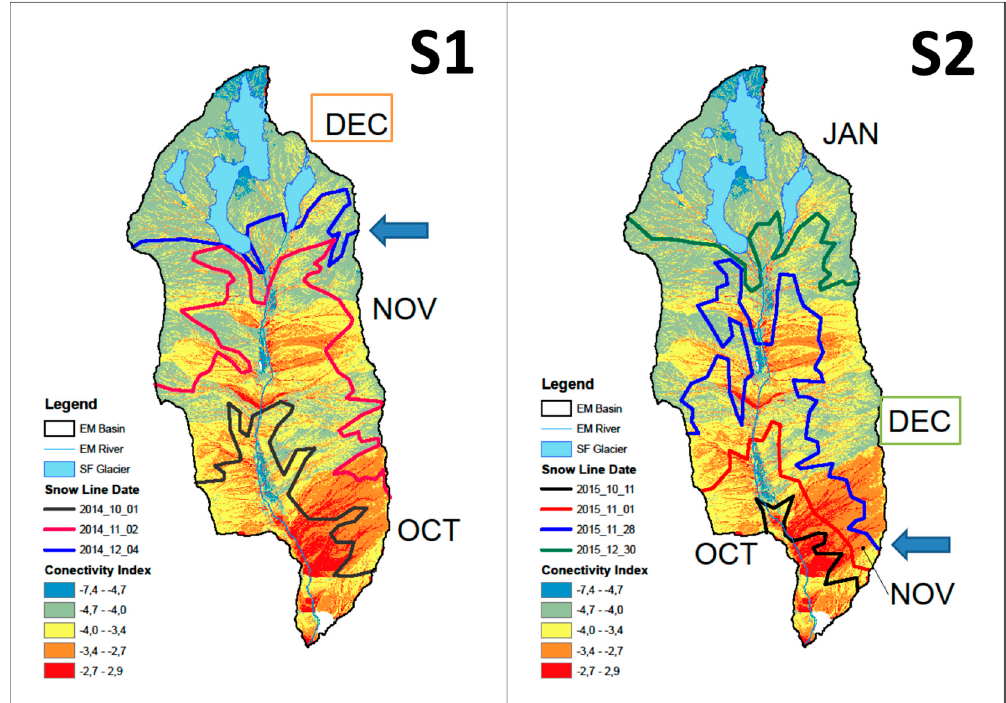
Figure 13. Connectivity map calculated using the connectivity index proposed by Cavalli et al. [7] and snow lines at the end of each month for the S1 ( left ) and S2 ( right ) ablation seasons. The color-coded lines on the map represent the zones between lines representing the limit of the snow on different months (OCT: October; NOV: November; DEC: December; JAN: January). The blue arrow indicates the line of snow cover in December